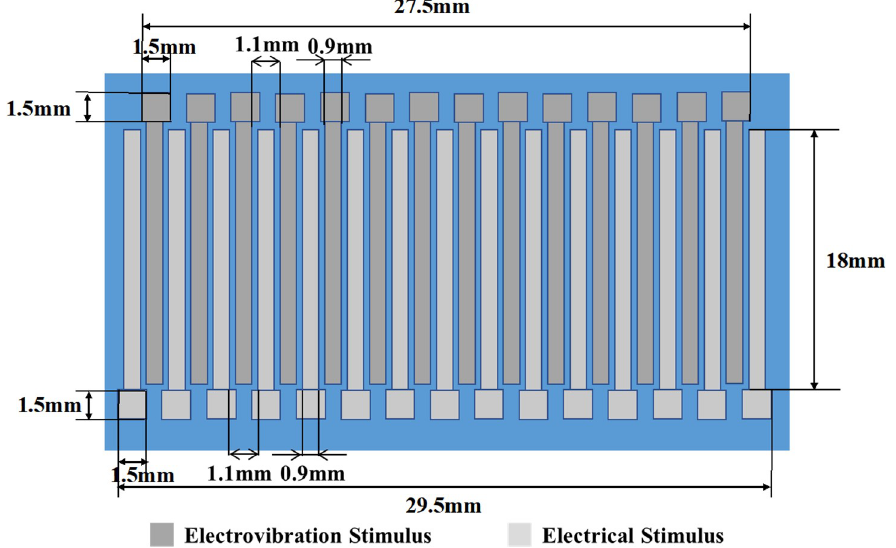
Figure 3. Design of the tactile display. The width and length of electrodes for each stimulus are 0.9 mm and 18 mm, respectively. The separation distance between the electrodes for each stimulus is 1.1 mm. Fifteen electrodes for each stimulus are arranged on a substrate.